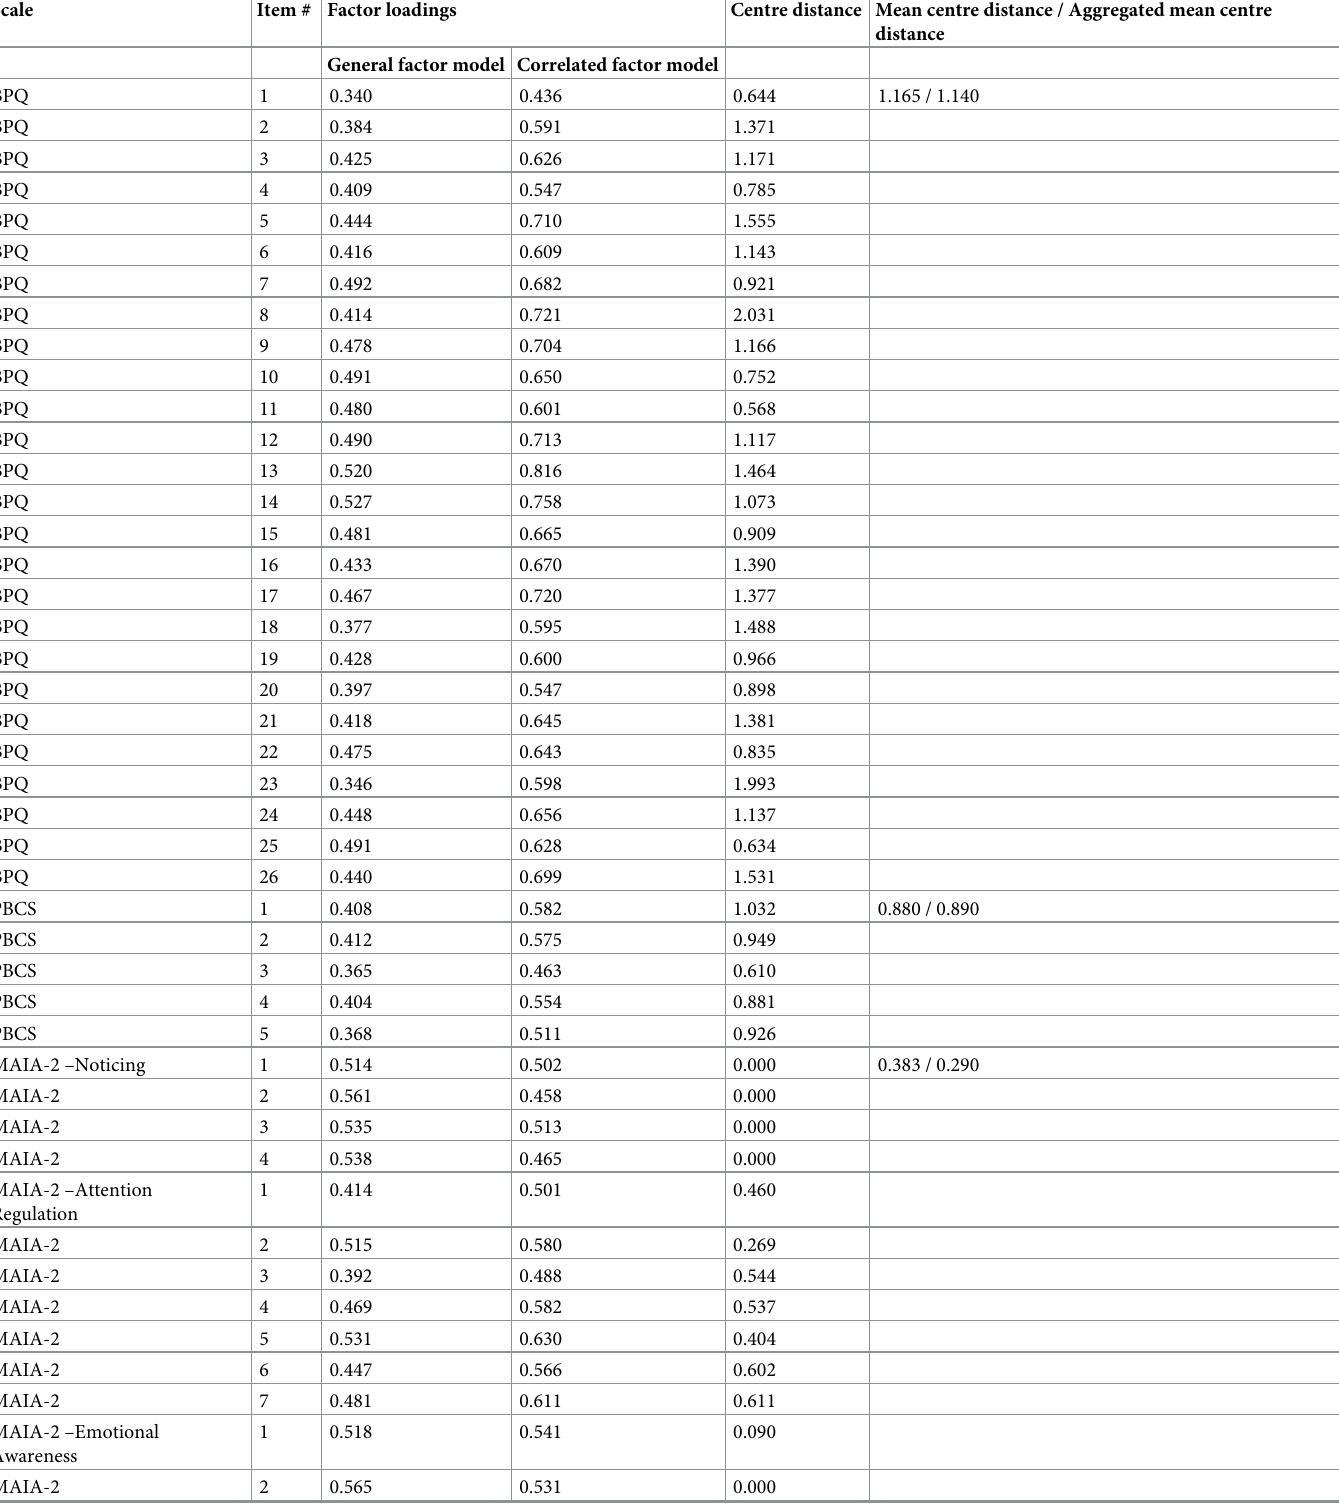
Table 3. Basic item pool visualisation calculations for the nested